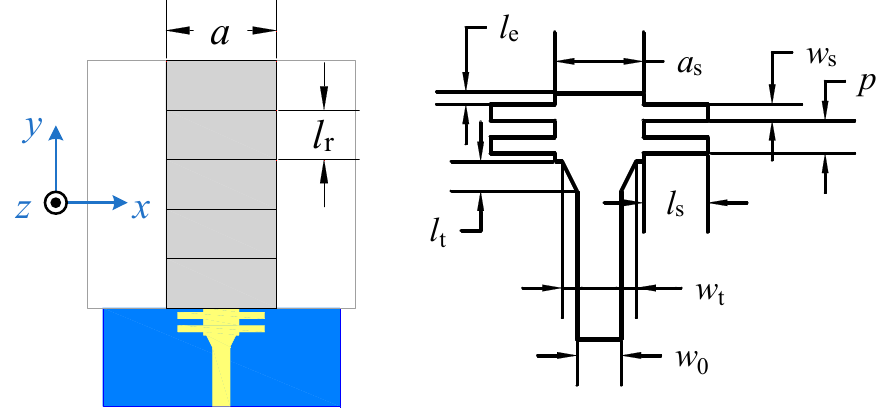
Figure 2. Vertical view of the proposed MSL-to-RWG transition, with the metallic strip area zoomed in.